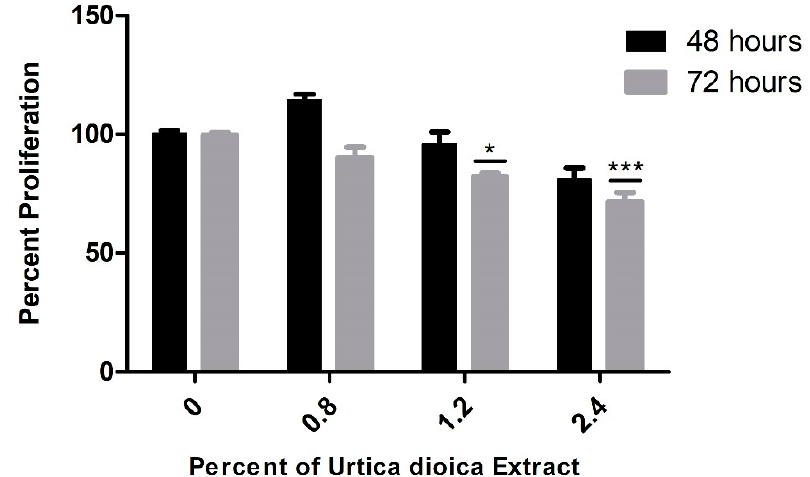
Figure 2. Effect of varying UD extract concentrations on the viability of normal B-lymphocyte cells after 48 and 72 h. UD extract exerted no major effect on the B lymphocytes after 48 h, with a minimal reduction effect after 72 h at the highest concentrations. The graph represents the means from three independent experiments +/ − SEM. *, **, and *** indicate p < 0.05, p < 0.001, and p < 0.0001, respectively, compared to the control group.